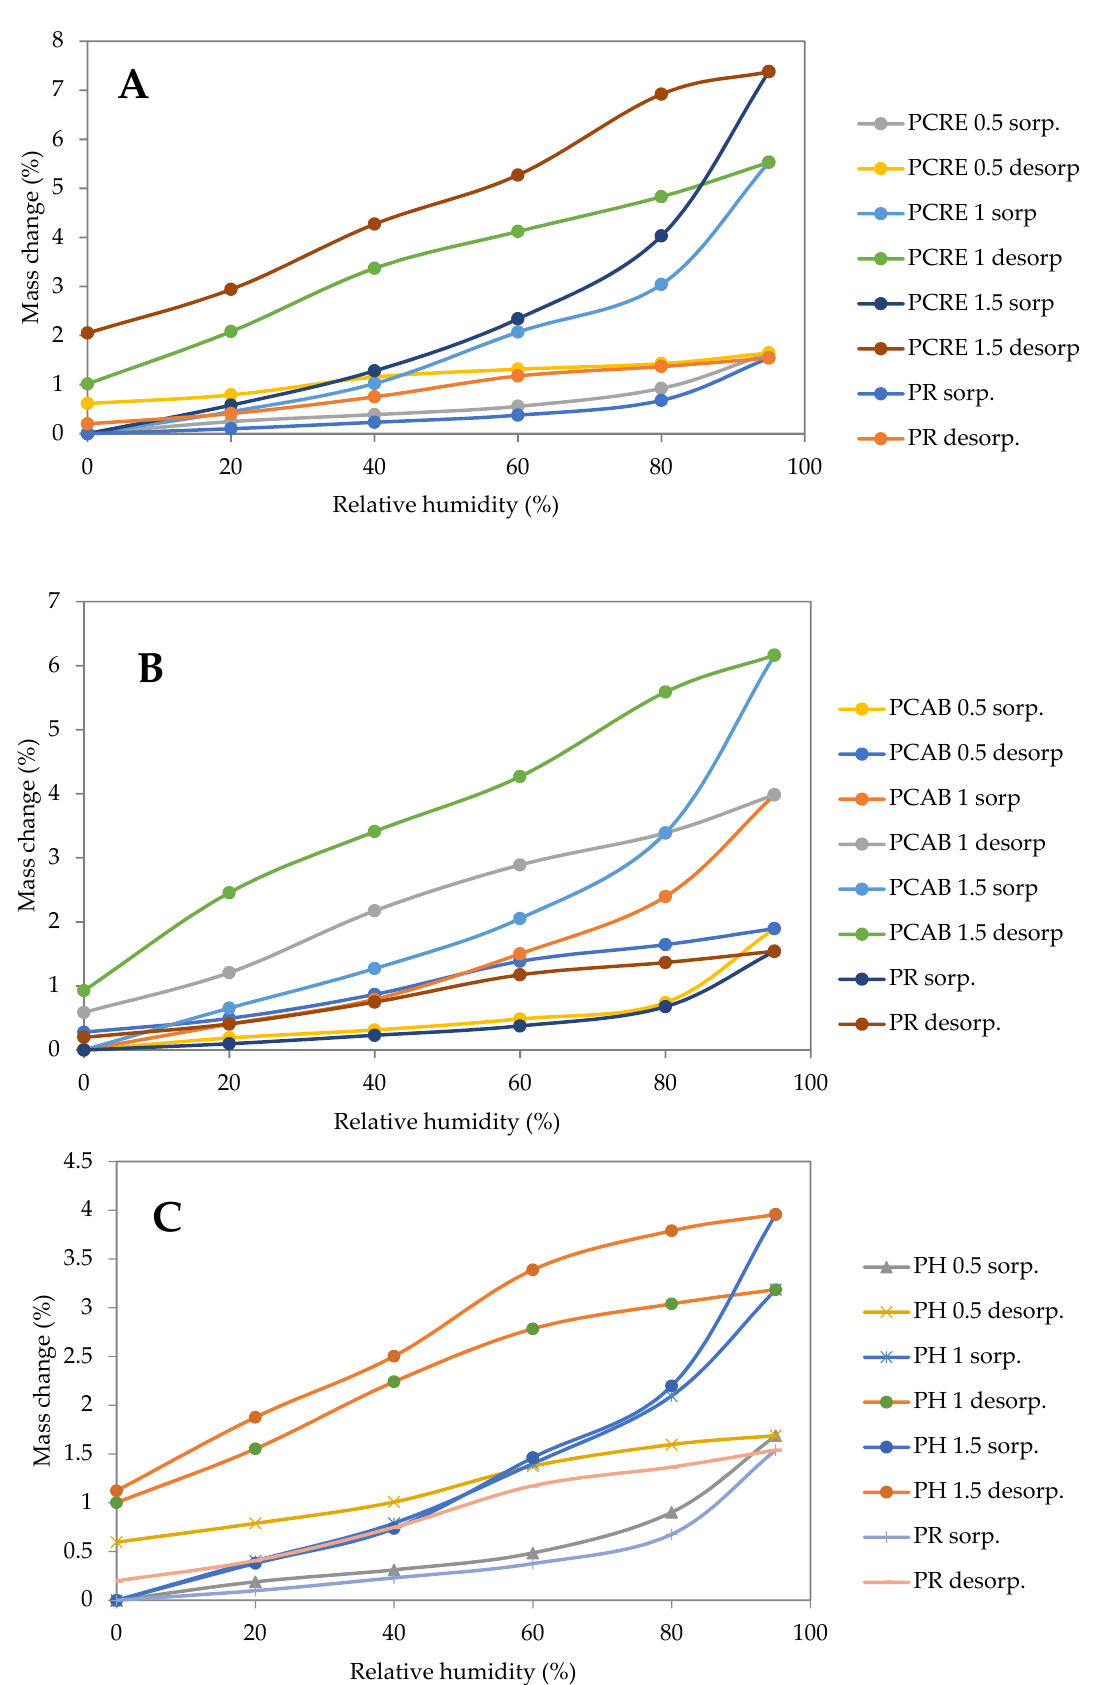
Figure 4. Sorption isotherms of studied plasters: ( A ) PCRE, ( B ) PCAB, ( C ) PH. The moisture retention curves showed a fast decrease of capillary pressure corre- sponding to the same moisture content with the increasing SAP dosage (Figure 5). This feature was related to the increased porosity (Figure 3) and could also be considered as positive for interior plasters with a humidity control function. On the other hand, here very minor variation was obtained, thus material performance is better depicted by sorp- tion and desorption curves. As shown in provided figures, most of the desorption curves exhibit a relatively slow rate of water vapor release in ranges between 95% and 80% RH, in particular. On the other hand, the desorption rate accelerates after being dropped below 80% RH.